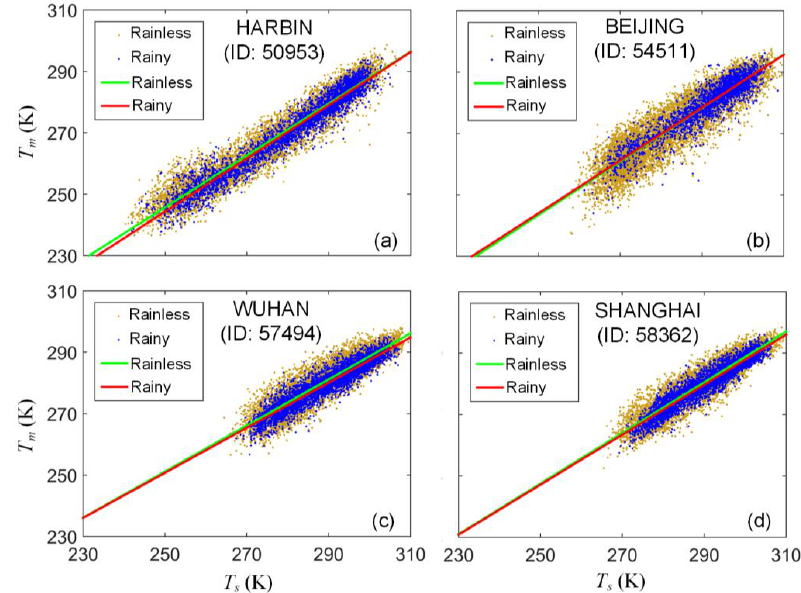
Figure 9. Rainy-day model and rainless-day model for station ( a ) HARBIN, ( b ) BEIJING, ( c ) WUHAN, and ( d ) SHANGHAI. The meanings of the lines and dots are the same as those in Figure 8. We compared the rainy-day model with the rainless-day model for each station. At half the stations, the difference between the two models is significant: the mean relative T between the two models is larger than 0.5%, or the maximal relative bias is bias of m larger than 1%. Figure 10 shows that the stations with significant difference between the rainy-day model and rainless-day model (red dots in Figure 10) distribute over a larger area than the stations with insignificant model difference (blue dots in Figure 10). In gen- eral, the stations with significant model difference are at higher altitudes (refer to Figure 1 for the topography), and they are mostly located in the west and north of China. This suggests that, in general, using weather-dependent models for rainy and rainless days T accuracy in the west and north of China, but separately will effectively improve the m not in the eastern part.